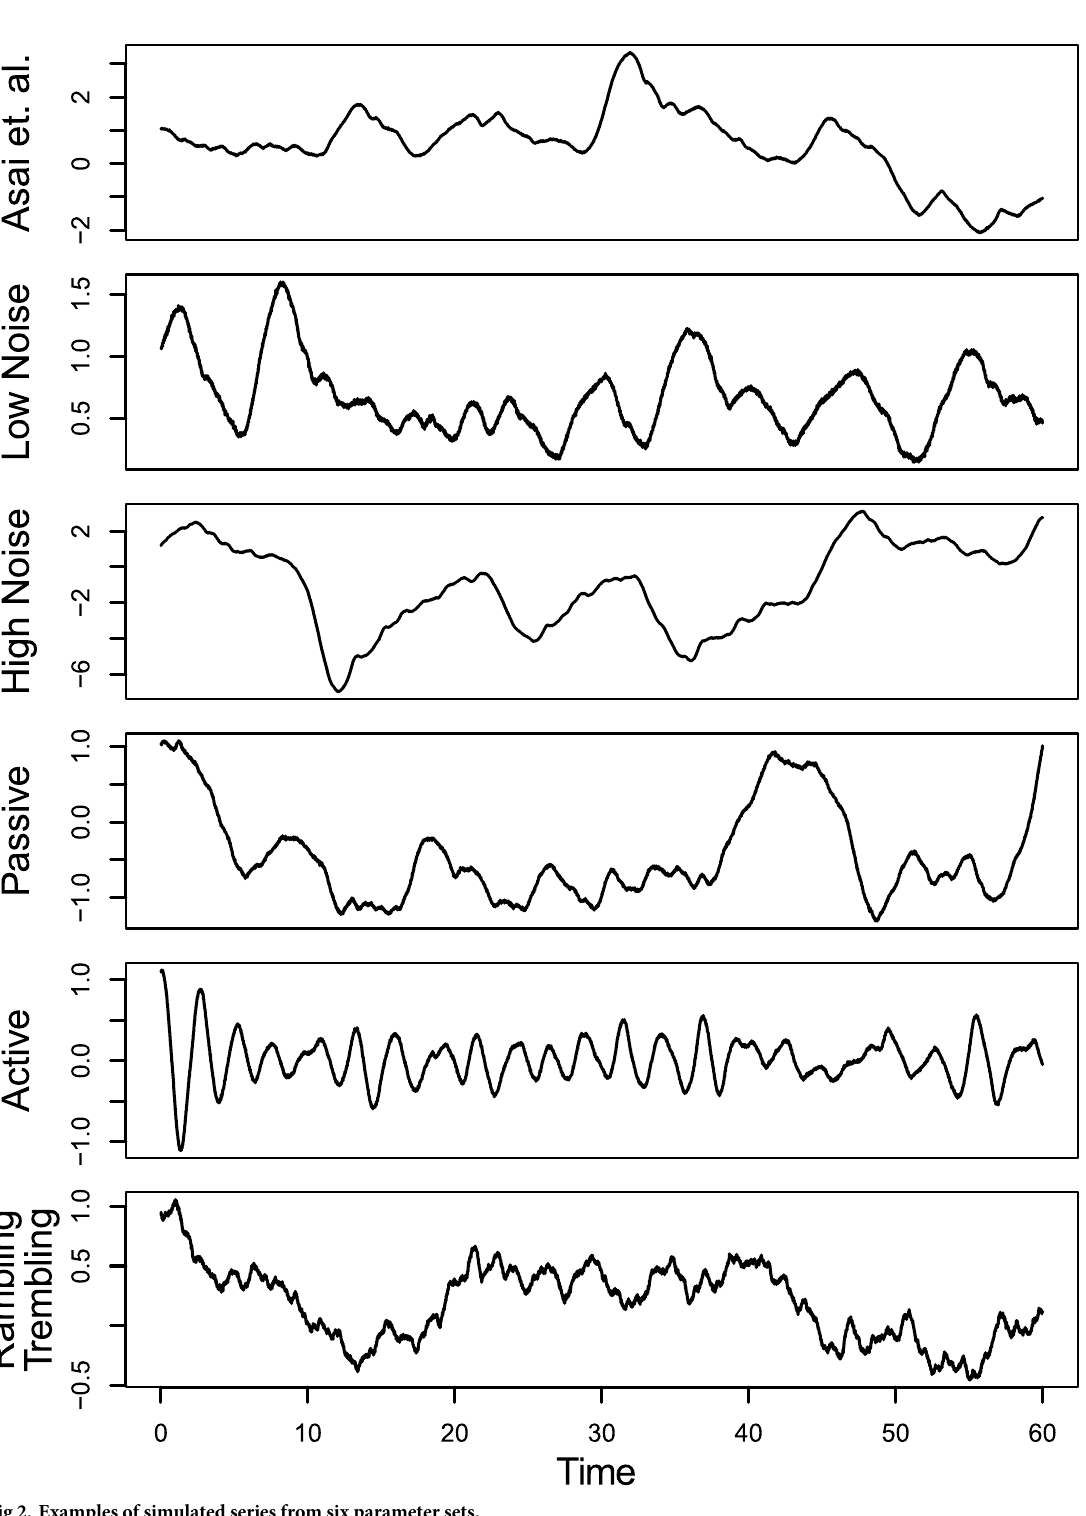
Fig 2. Examples of simulated series from six parameter sets.